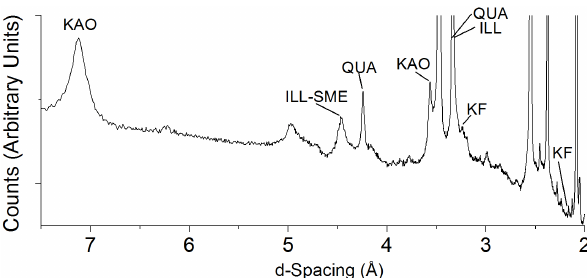
Fig. 1. Sample X-Ray diffraction pattern showing assignments of major mineral components in soil D. Assigned are a selection of the peaks associated with the major components found in the soil dusts. Labelled are peaks for KAO – Kaolinite, ILL-SME – Illite- Smectite, QUA – Quartz, ILL – Illite, KF – Potassium Feldspar. Note that assignments shown in the figure are not exhaustive; ex- tensive information on peak positions can be found in Hillier (1999,